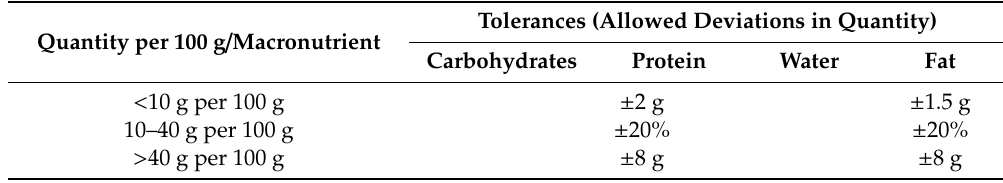
Table 2. Tolerated di ff erences in nutrition content in foods besides food supplements.